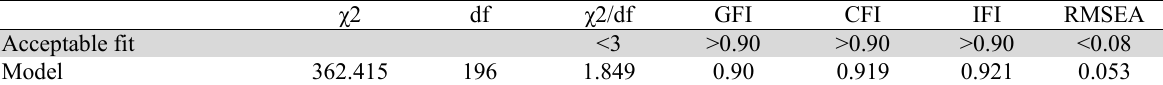
Model fit indices for formative assessment Scale (Measurement model)